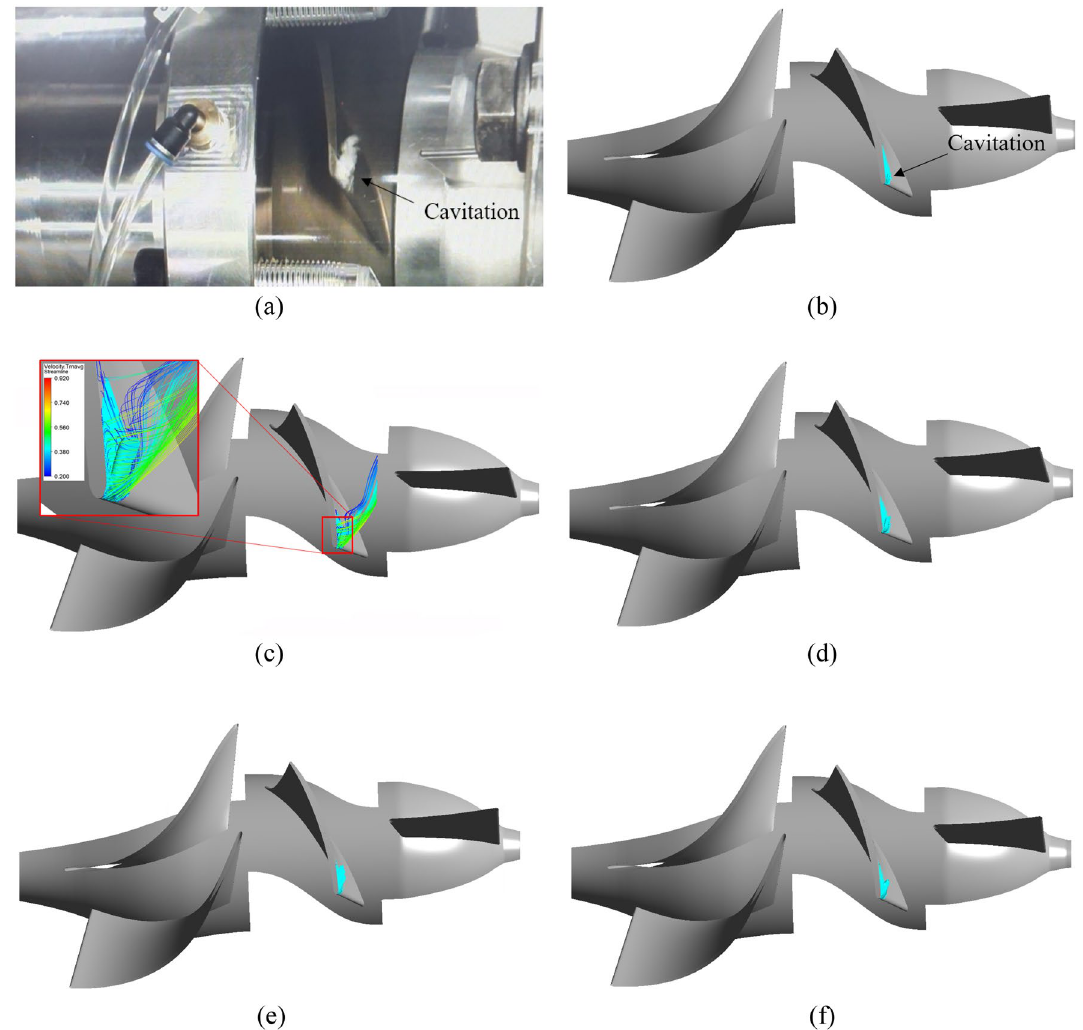
Figure 13. Internal flow comparison of experiment with different flow intensities in numerical result at 0.6 ϕ d